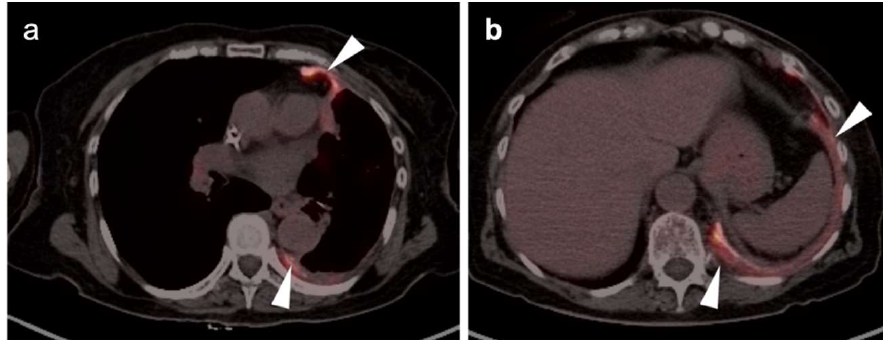
Figure 14. Malignant pleural mesothelioma ( a – c ). Bulky hypermetabolic soft tissue within the pleural space of the left lung ( white arrowheads ), associated with a large left pleural effusion and atelectatic collapse of the left lower lobe. Small focal areas of metabolic activity in the collapsed left lower lobe could be metastatic foci versus areas of superimposed inflammatory change ( white arrow ).